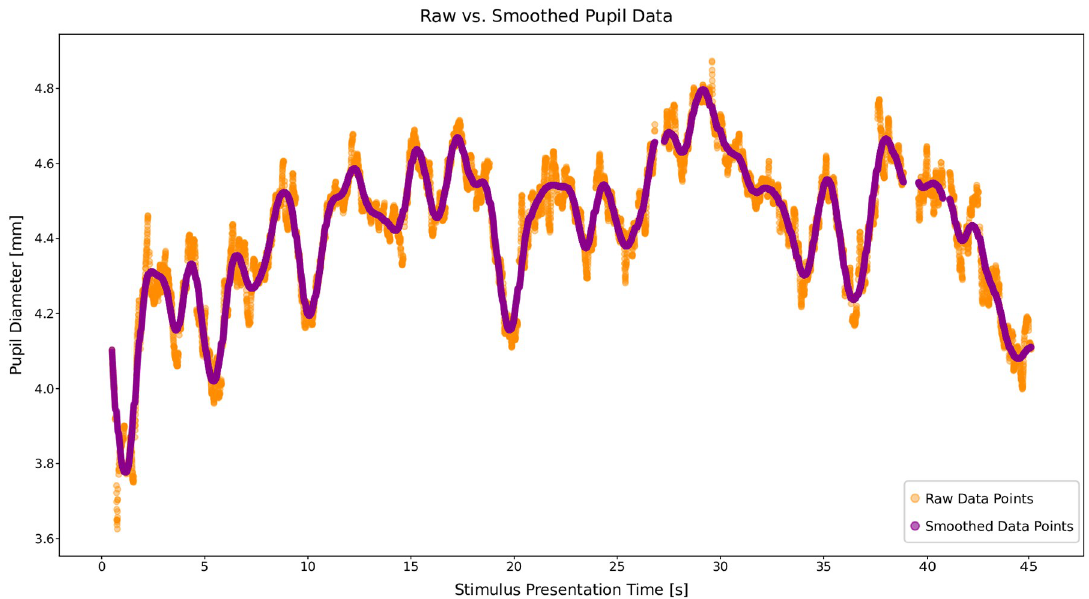
Fig 4. Smoothed pupil signal. Raw signal from the left eye (orange) and the smoothed signal (purple) with a Butterworth filter with 2Hz